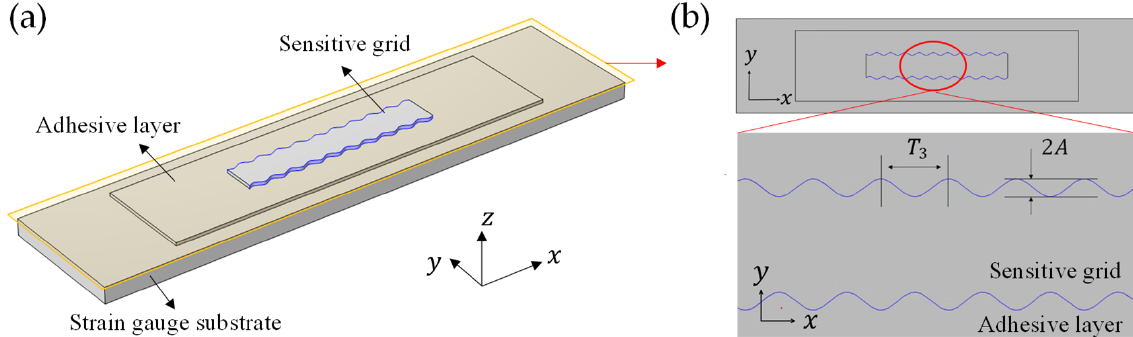
Figure 6. Schematic diagram of the side-wall profile model ( a ) and its crossed section view ( b ).